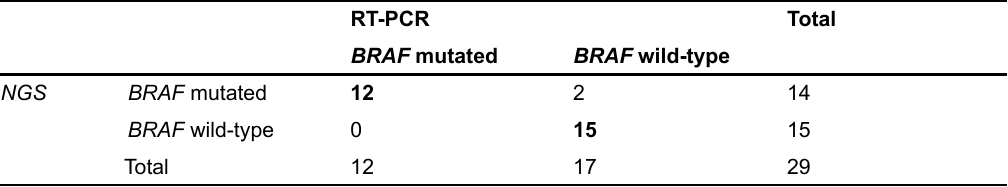
NGS methods. Table 1. Concordance of BRAF mutational status established by RT-PCR and NGS methods RT-PCR Total BRAF mutated BRAF